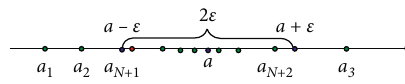
Figure 2: “ ε-N ” definition of the limit of an series of